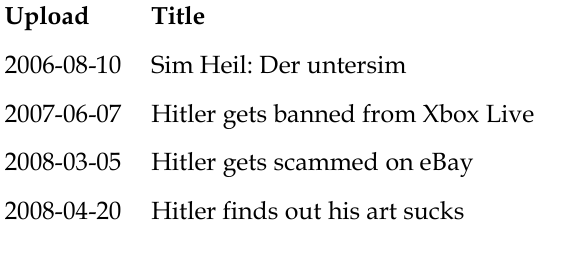
Table 1: List of instances of the Downfall meme analysed. Data collected in April